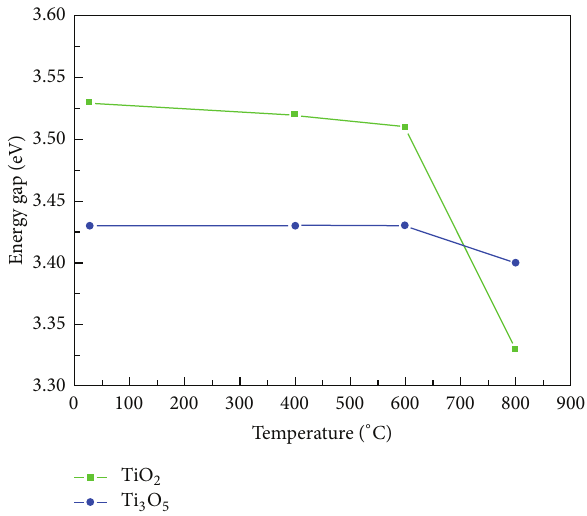
Figure 8: Optical band gap of as-deposited, annealed at 400 ∘ C, 600 ∘ C, and 800 ∘ C.